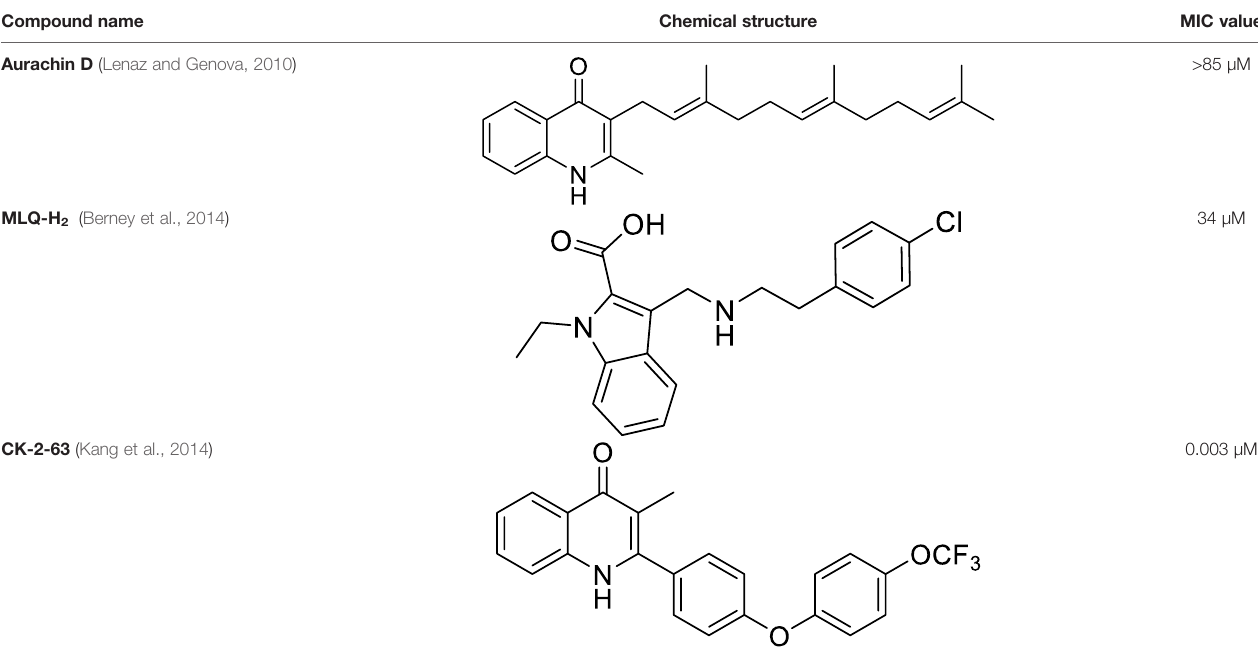
TABLE 2 | Summary of cytochrome bd oxidase inhibitors, their chemical structures and MIC values. Number in the parentheses denotes the references.